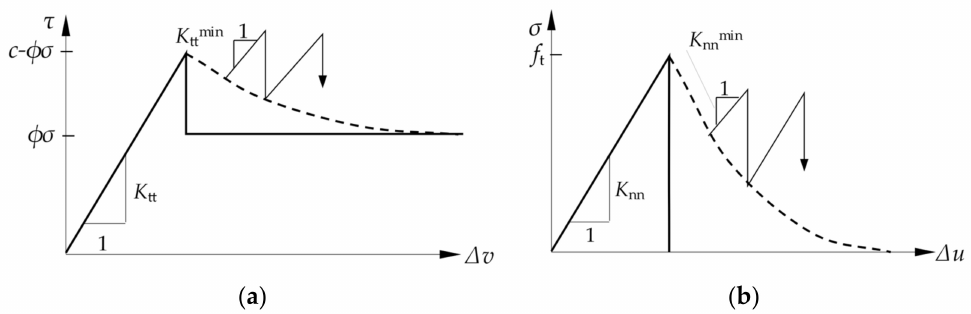
Figure 13. The behavior of the interface model. ( a ) In shear; ( b ) in